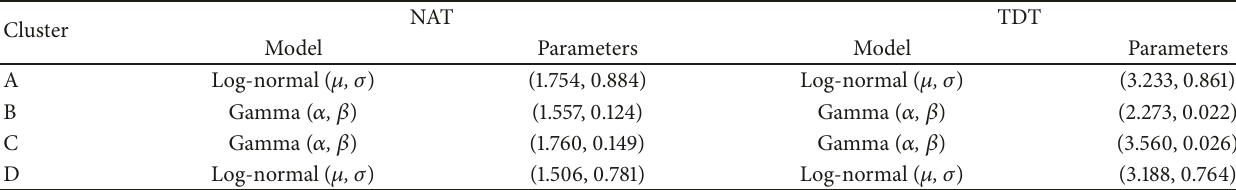
Table 6: Parameters of the best distribution models.